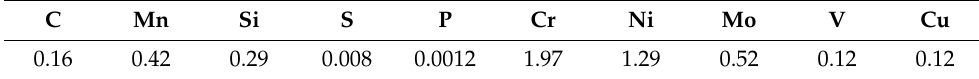
Table 1. Chemical composition (wt.%) of the 15Kh2NMFA material.